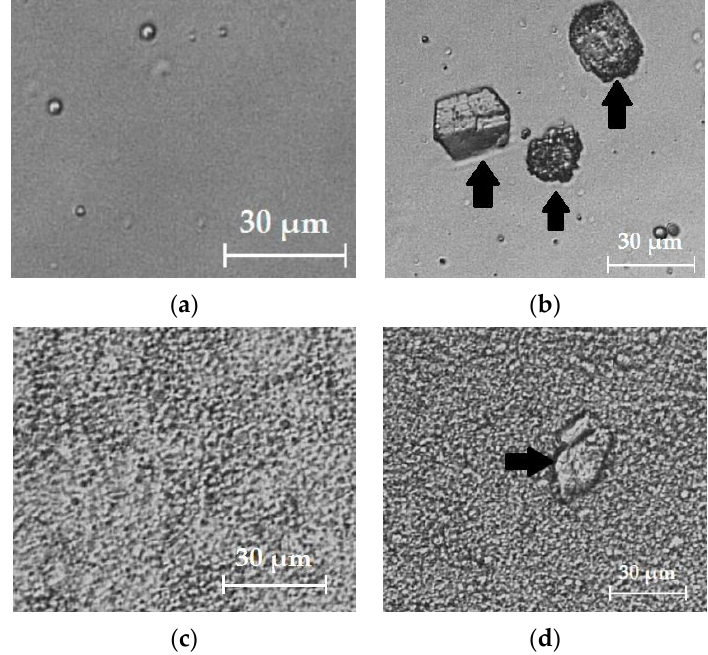
Figure 3. Microscopy images of formulations F3 and F5. Images were captured using an optical microscope Olympus IM coupled to a Sony camera XCD-U100CR at 924× magnification. ( a ): F5, solubilized rapamycin hydro-alcoholic gel (0.1% w / w ); ( b ): F5, suspended rapamycin hydro-alcoholic gel (0.5% w / w ); ( c ): F3, solubilized rapamycin Excipial ® cream (0.1% w / w ); ( d ): F3, suspended rapamycin Excipial ® cream (2% w / w ). Rapamycin crystals are indicated by the black arrows.